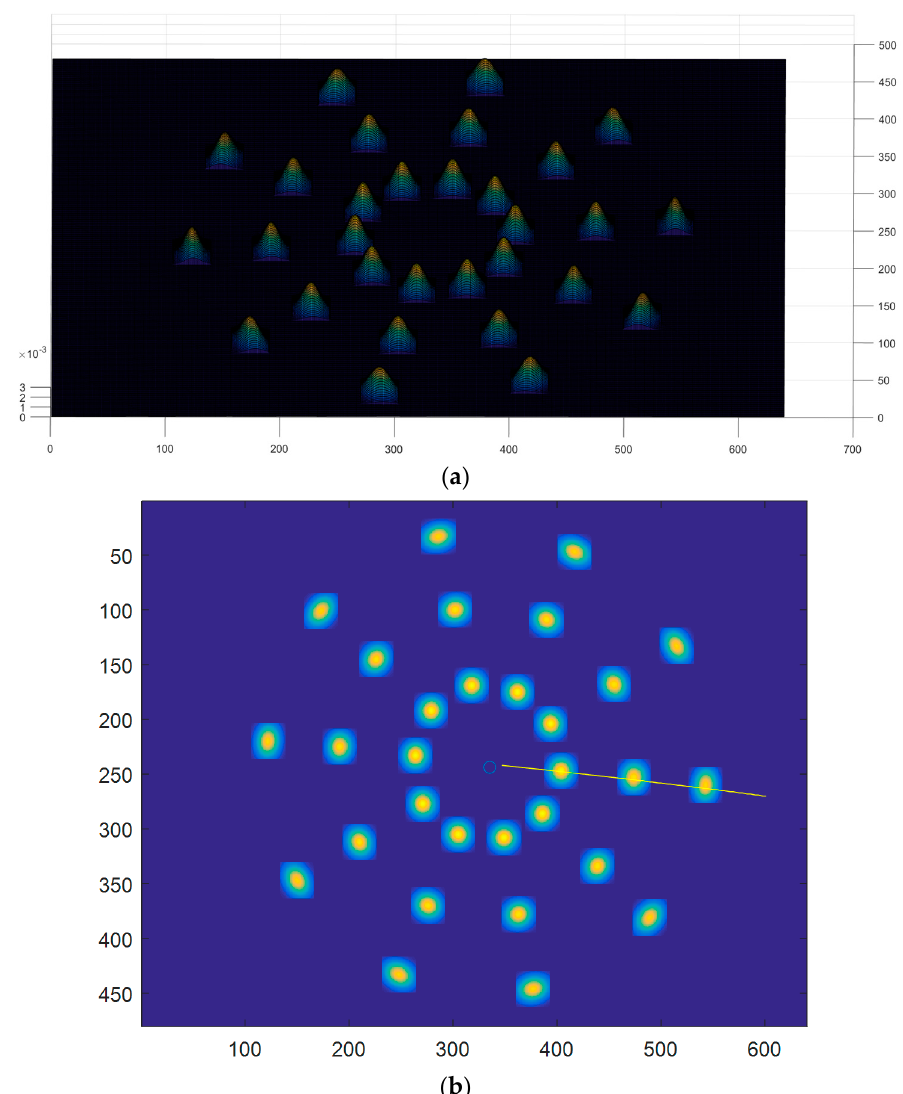
Figure 5. The Gaussian defined in Equation (9) at different positions on the fisheye image, using the geodetic distance is shown in ( a ) 3D and ( b ) as color-encoded image.